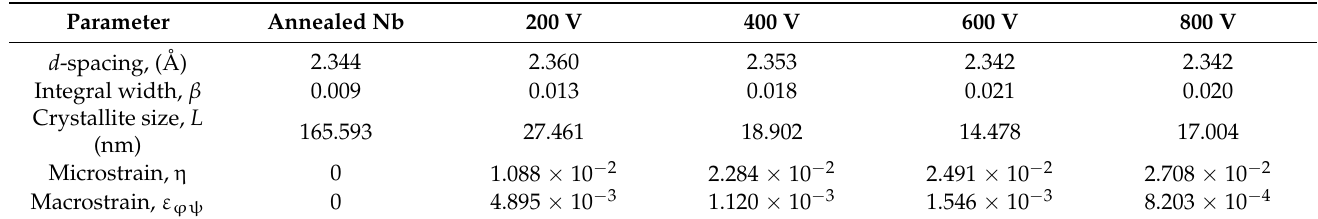
Table 6. Crystallographic parameters of Nb-coated 316L at the various voltages.